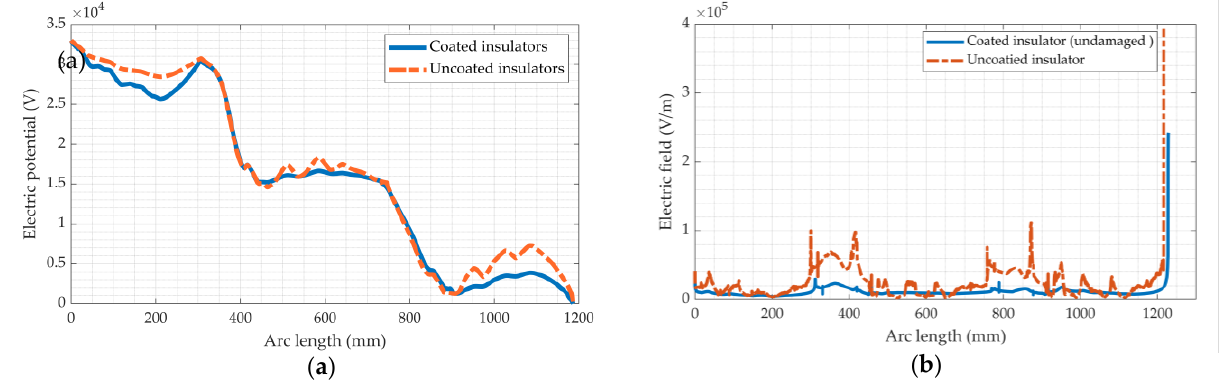
Figure 14. Simulation results of coated and uncoated insulators: ( a ) electric potential; ( b ) electric field.